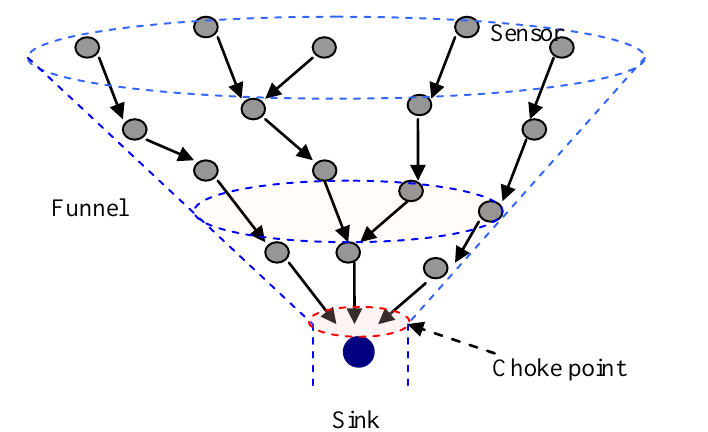
Figure 2. Funneling